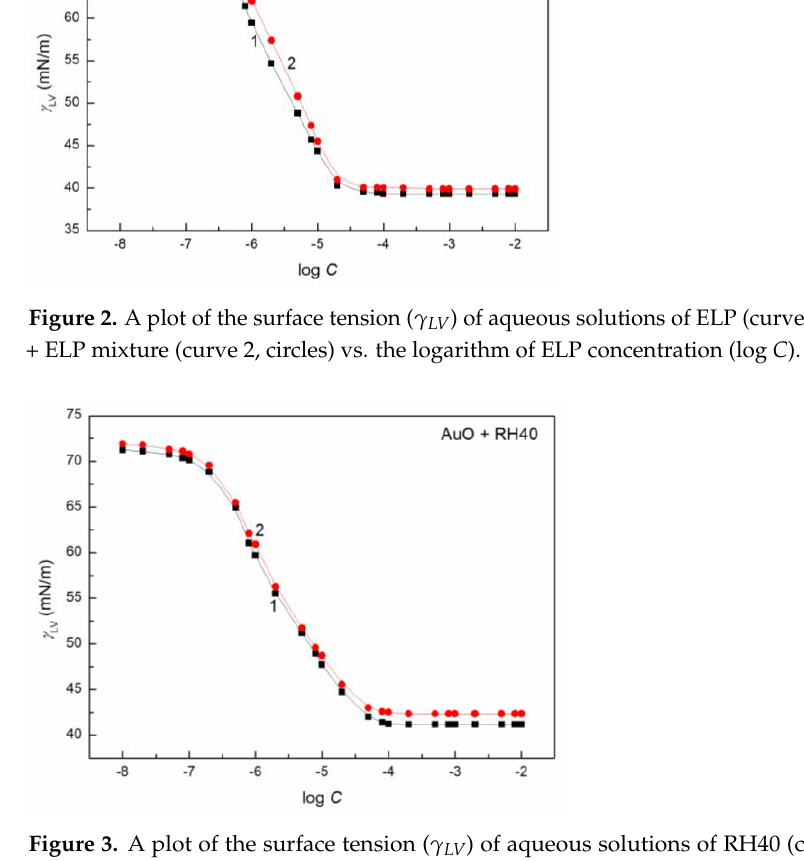
Figure 3. A plot of the surface tension ( 𝛾 𝐿𝑉 ) of aqueous solutions of RH40 (curve 1, squares) and AuO + RH40 mixture (curve 2, circles) vs. the logarithm of RH40 concentration (log C ).